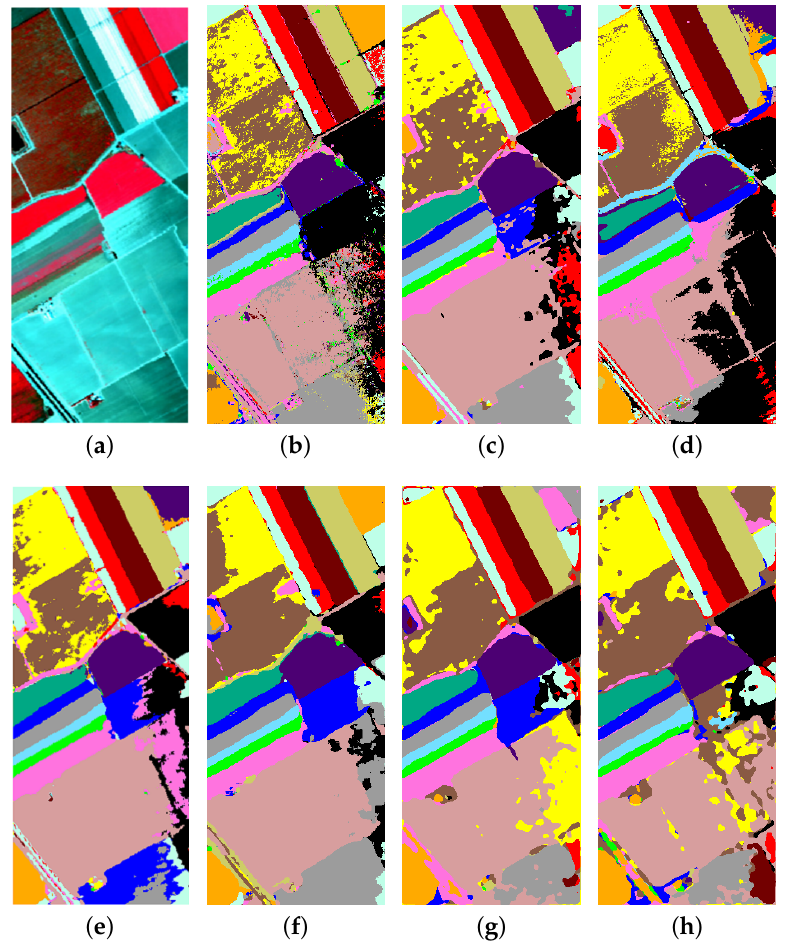
Figure 12. Classification maps predicted by different methods for Salinas dataset. ( a ) Ground-truth, ( b ) 3-D CNN (88.54 %), ( c ) SSRN (93.23%), ( d ) SSUN (92.14%), ( e ) S-DMM (93.37%), ( f ) CNN-AL-MRF